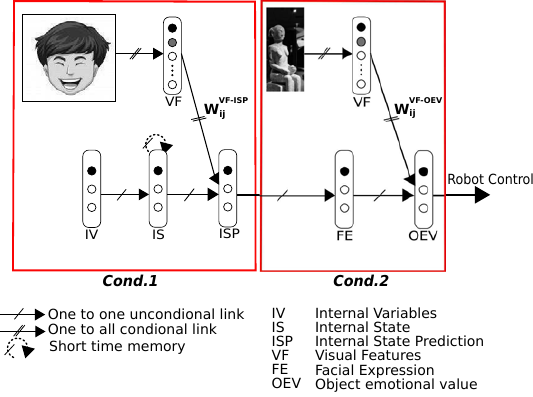
Figure 3: Social referencing model. The recognised facial expres- sions is used as an unconditional stimulus to associate an emo- tional state with an object or a